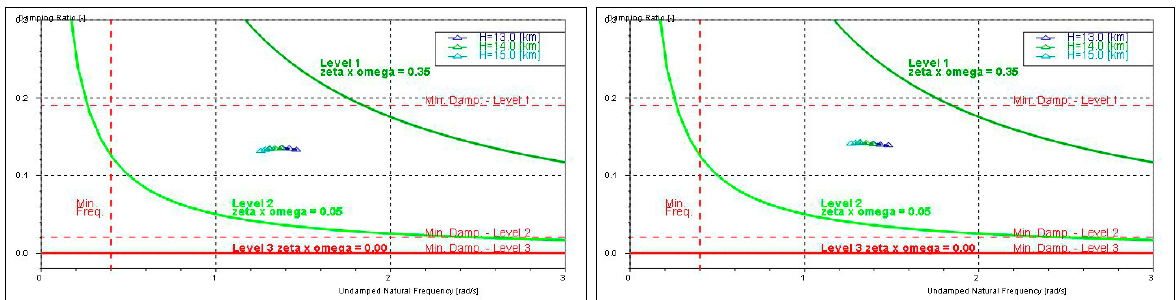
17. The damping coefficient for the dutch roll with stability criteria based on the MILfor configuration No. 1 (on the left) and configuration No. 2 (on the right)